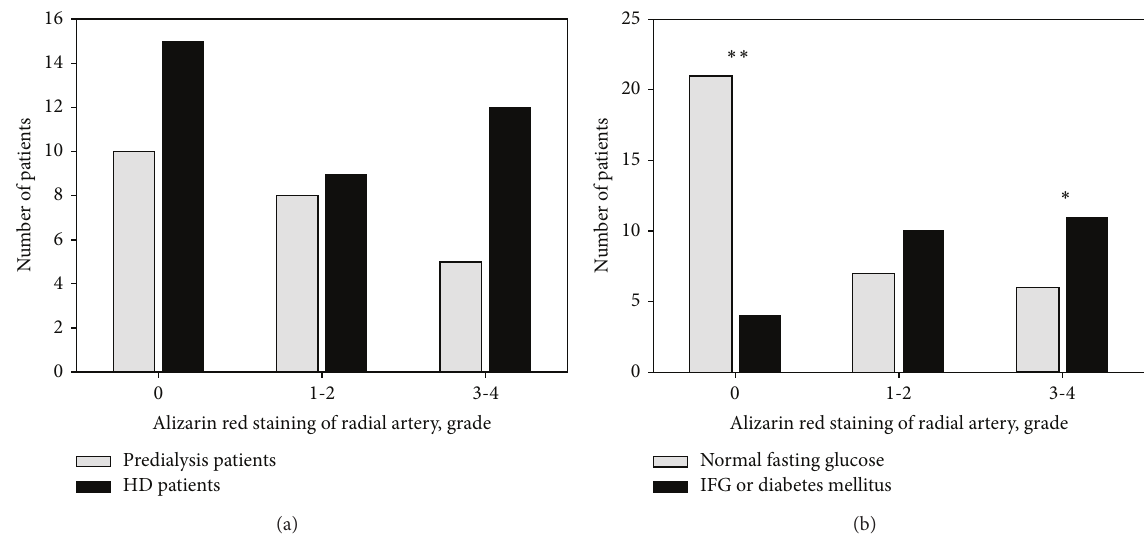
Figure 2: Advancement of vascular calcification as assessed by alizarin red staining in radial arteries: 0: no mineral deposits in arterial wall, 1-2: mild calcification, and 3-4: advanced calcification. (a) Calcification in predialysis patients versus HD patients ( 𝑃 = 0.6 in chi-squared test). (b) Calcification in patients with normal fasting glucose ( < 5.6mmol/L) versus IFG (prediabetes) or diabetes ( 𝑃 = 0.002 in chi-squared test; 𝑃 = 0.004 ( ∗∗ ) and 𝑃 = 0.03 ( ∗ ) in post hoc tests). IFG: impaired fasting